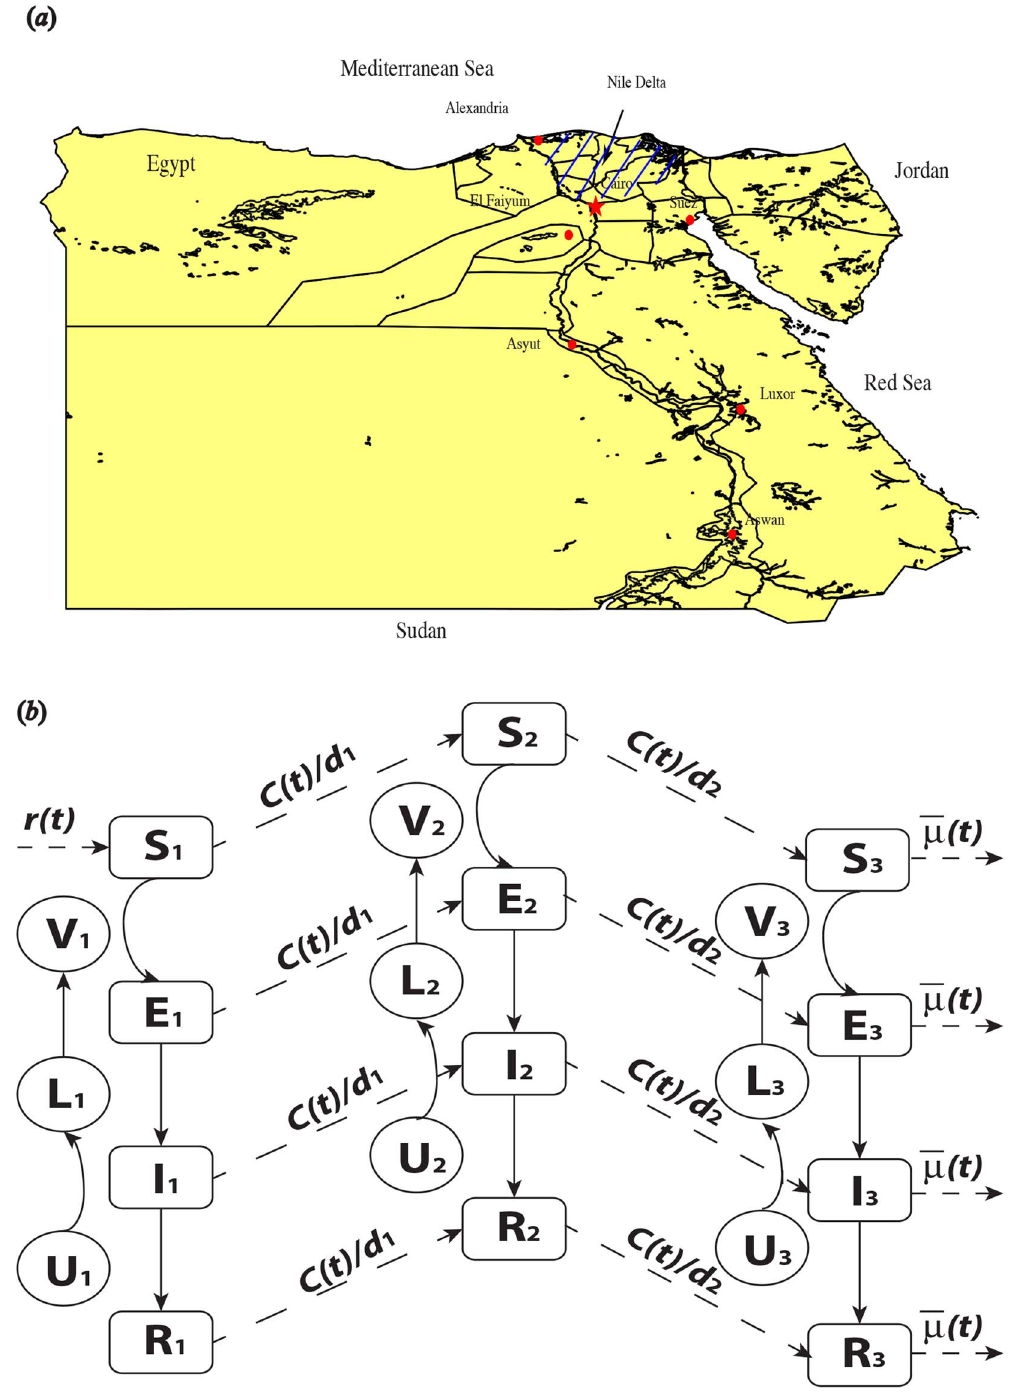
Fig. 1. Map of Rift valley fever in Egypt and flow chart. (a) Map of Egypt; (b)The flow chart of RVFV transmission and spatial dispersal. The sub- script i represents the related compartment in patch i , and the other parameters are listed in Table 2. Only the first patch has import of livestock, and then livestock, regardless of infection status, move from patch 1 to patch 3, via patch 2 with human demand. Within each of the patches, the disease pathogens are transmitted between livestock and mosquitoes causing infections. Directions in dash represent the seasonally or socioeconomically driven flows.